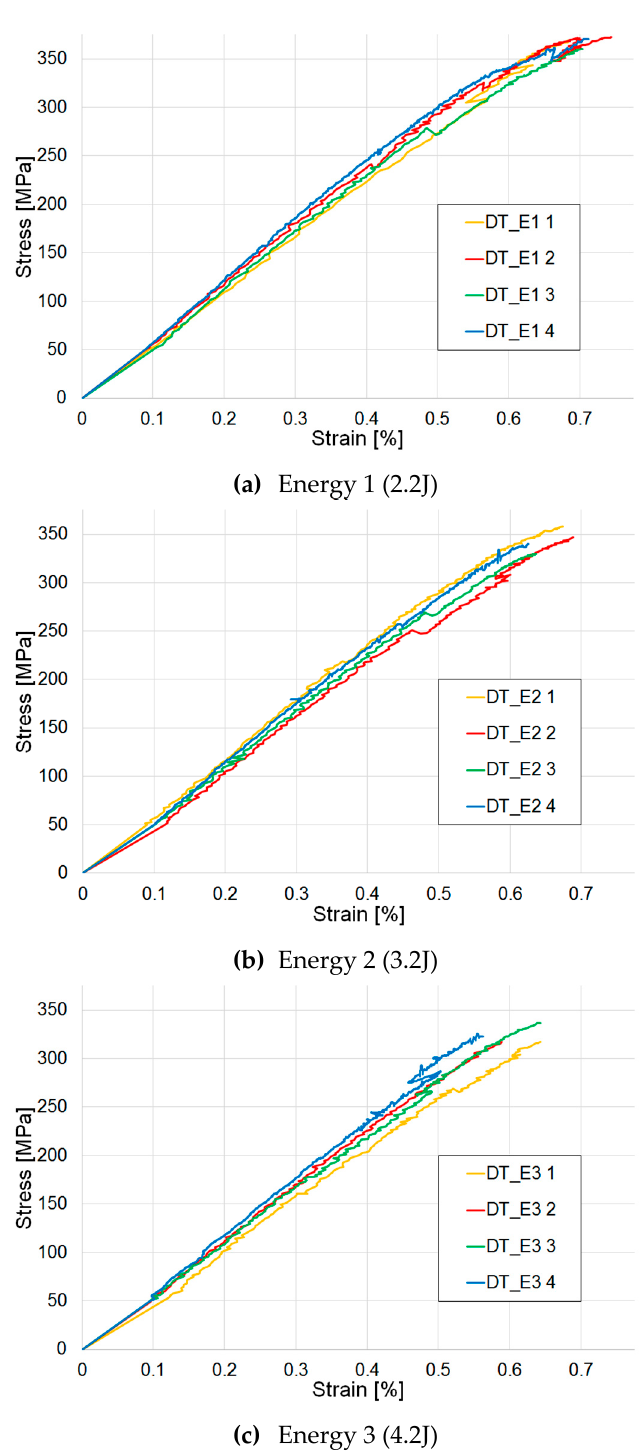
Figure 11. Tensile tests: post-impact results. ( a ) samples impacted at 2.2 J (DT_E1), ( b ) samples impacted at 3.2 J (DT_E2), ( c ) samples impacted at 4.2 J (DT_E3).